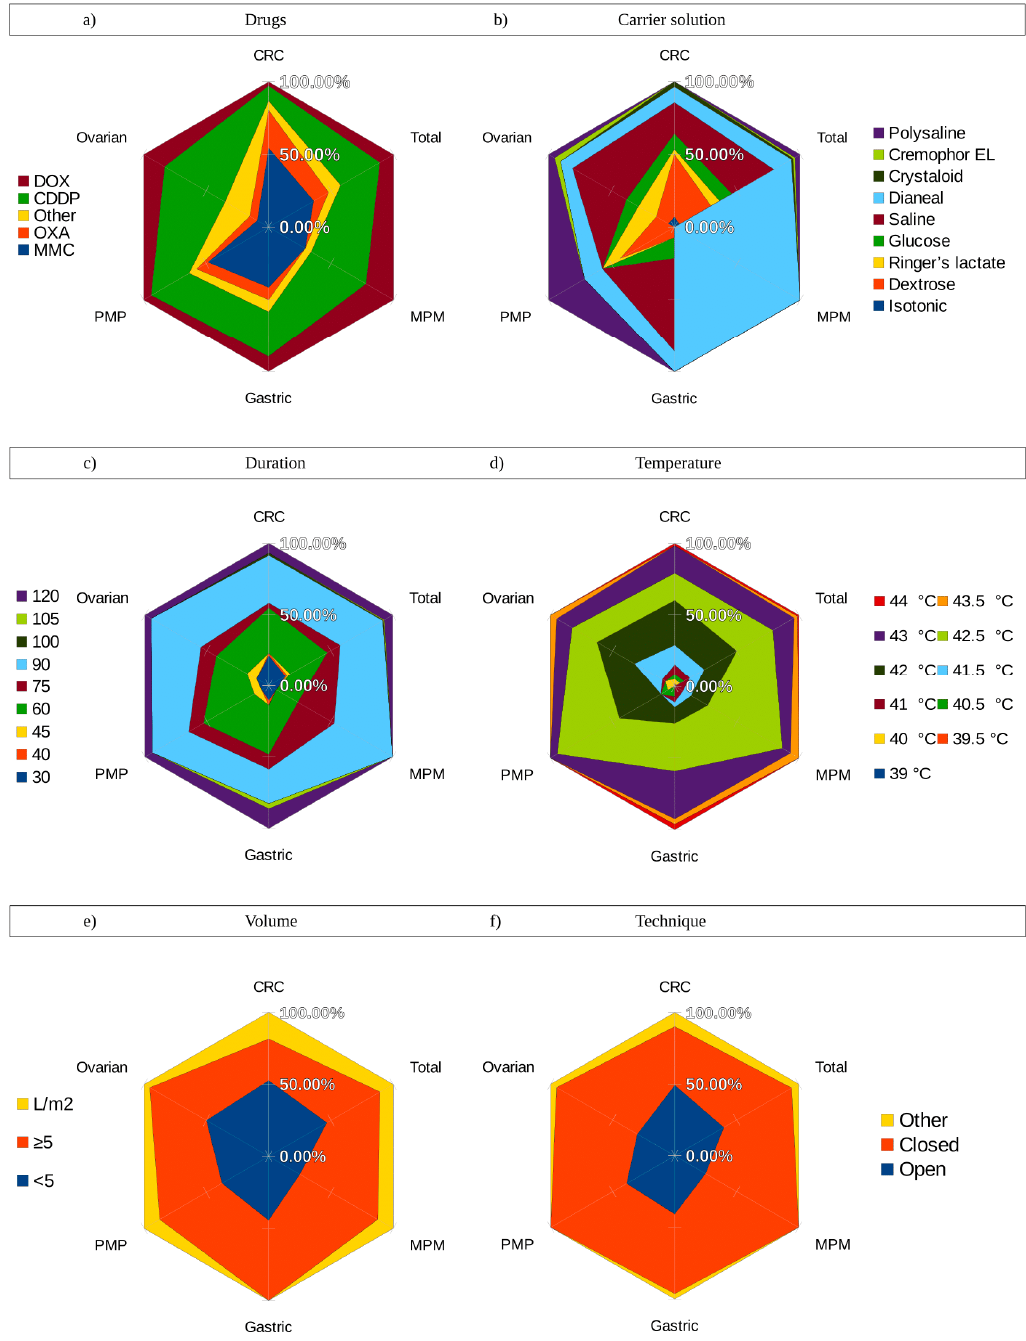
Figure 5. Data collected from the literature for six parameters influencing the efficacy of HIPEC: ( a ) Drugs; ( b ) carrier solution; ( c ) duration; ( d ) volume; ( e ) temperature; and ( f ) technique. CRC: colorectal cancer; PMP: pseudomyxoma peritonei; MPM: malignant peritoneal mesothelioma.